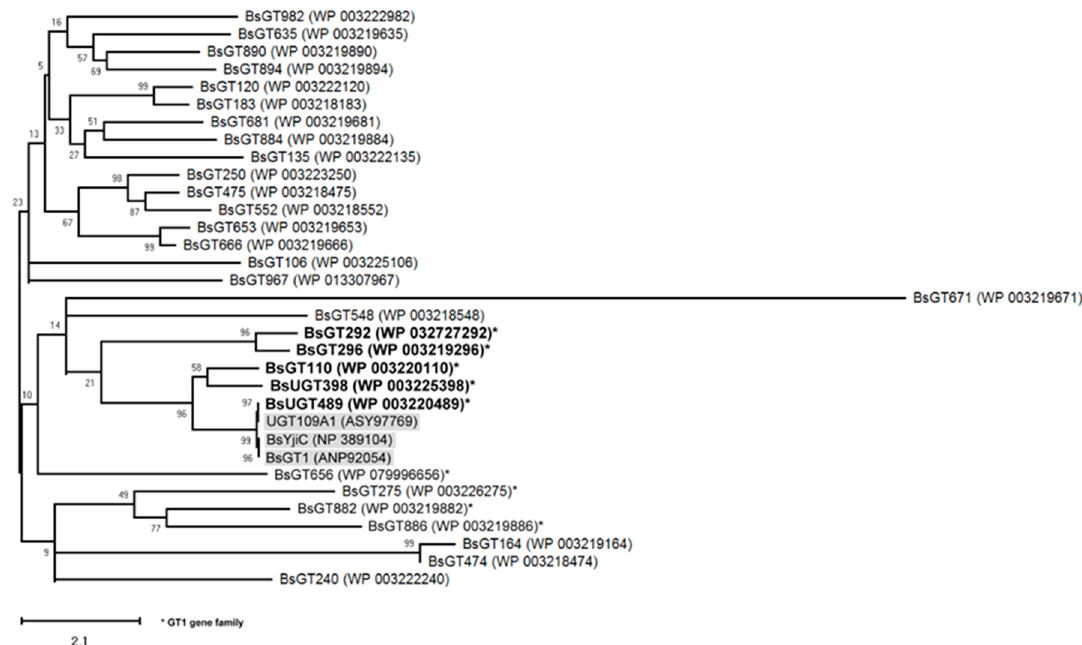
Figure 2. Molecular phylogenetic analysis of BsGT candidates inferred with the maximum likelihood (ML) method. The best-fit ML model selection is mtREV24 [23]. The tree with the highest log likelihood ( − 6498.11) is shown. The percentage of trees in which the associated taxa clustered together is shown next to the branches. Initial tree(s) for the heuristic search were obtained automatically by applying the neighbor-join and BioNJ algorithms to a matrix of pairwise distances estimated using a JTT model and then selecting the topology with the superior log likelihood value. The tree is drawn to scale, with the branch lengths measured in the number of substitutions per site. The analysis involved 10 amino acid sequences. All positions with less than 95% site coverage were eliminated. That is, fewer than 5% alignment gaps, missing data, and ambiguous bases were allowed at any position. There were a total of 372 positions in the final dataset. Evolutionary analyses were conducted in MEGA X [24].